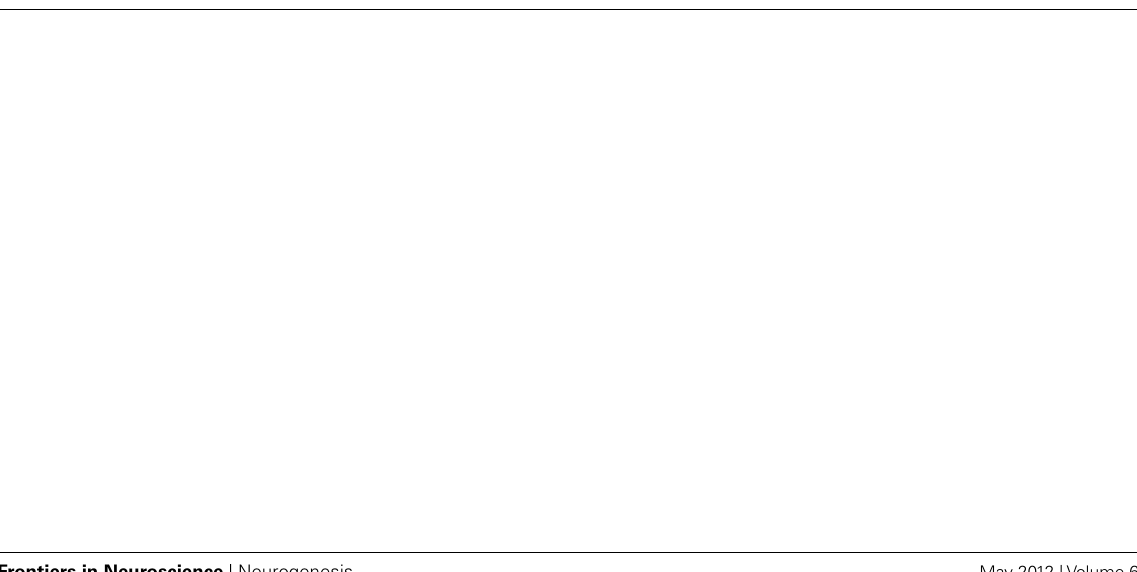
FIGUREA6 | Clustering approach to identify potential novel REST miRNA targets. In unsupervised clustering analyses, known REST miRNA targets formed clusters that also contained other miRNAs. Cluster 1 and 2 were chosen as representative examples and